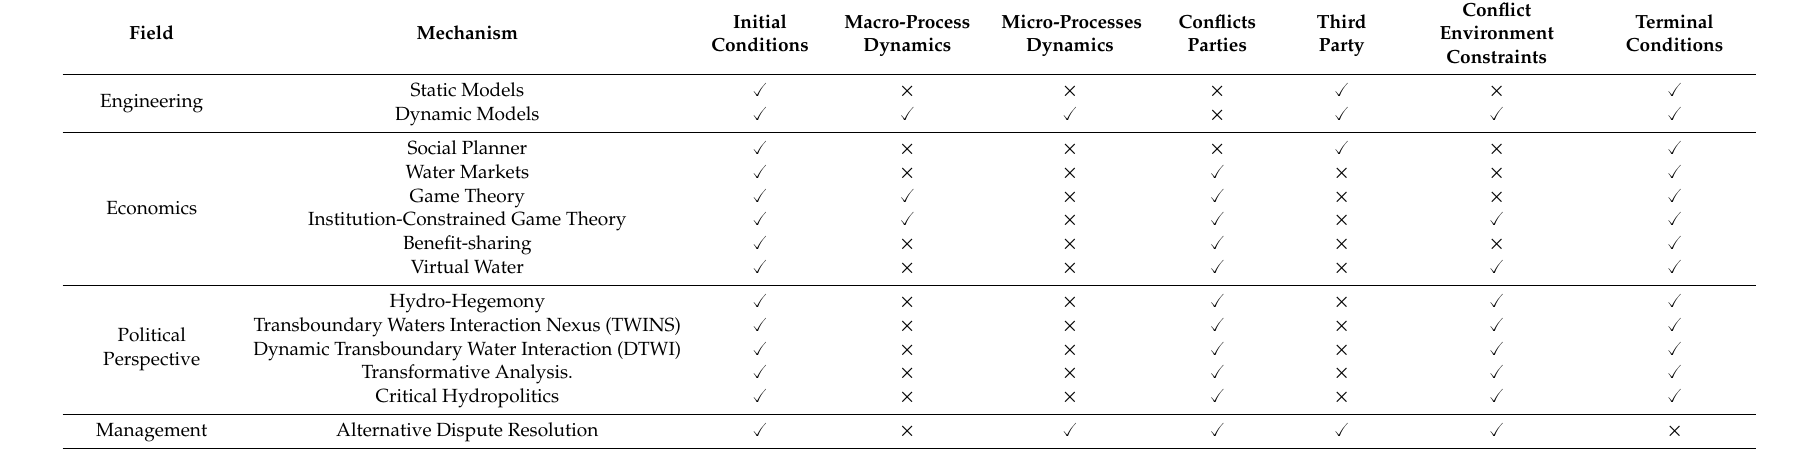
Table 11. Transboundary water conflict resolution mechanisms: structural